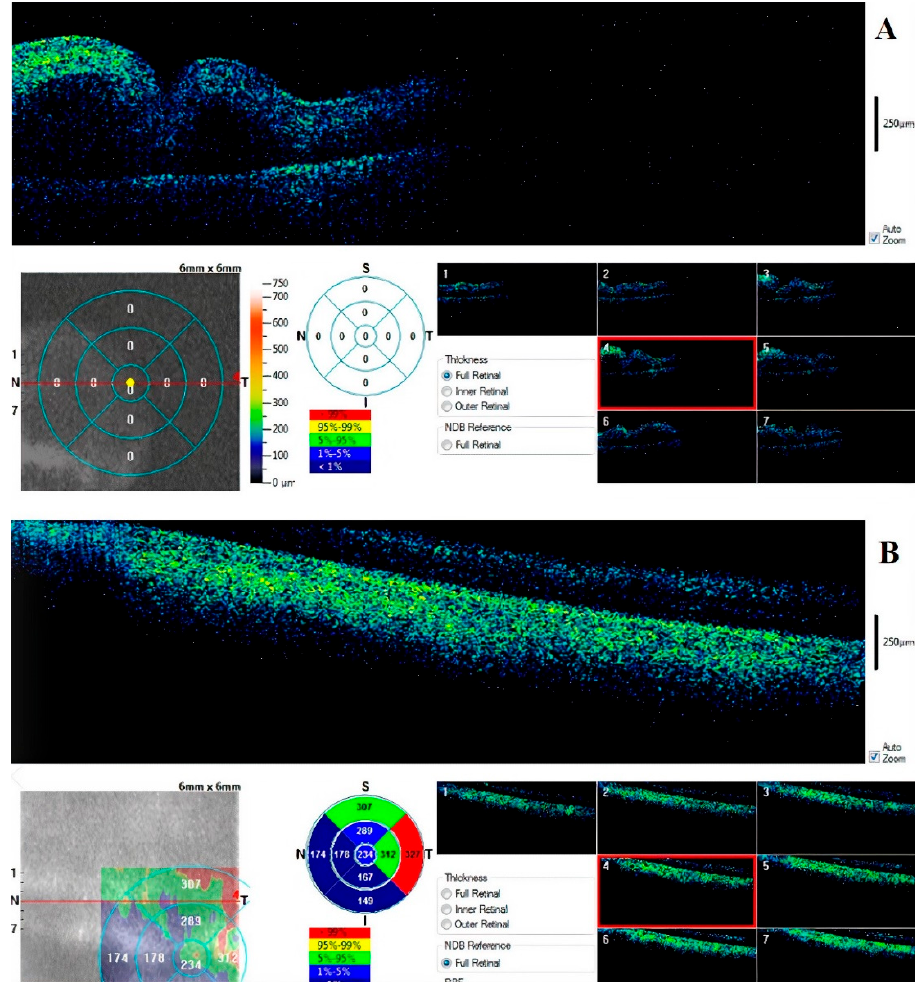
Figure 6. Retinal ( A ) full map and foveal scan at 6th hour ( B ). There is an appreciable separation between the inner and outer layers and early degeneration of nervous tissue.